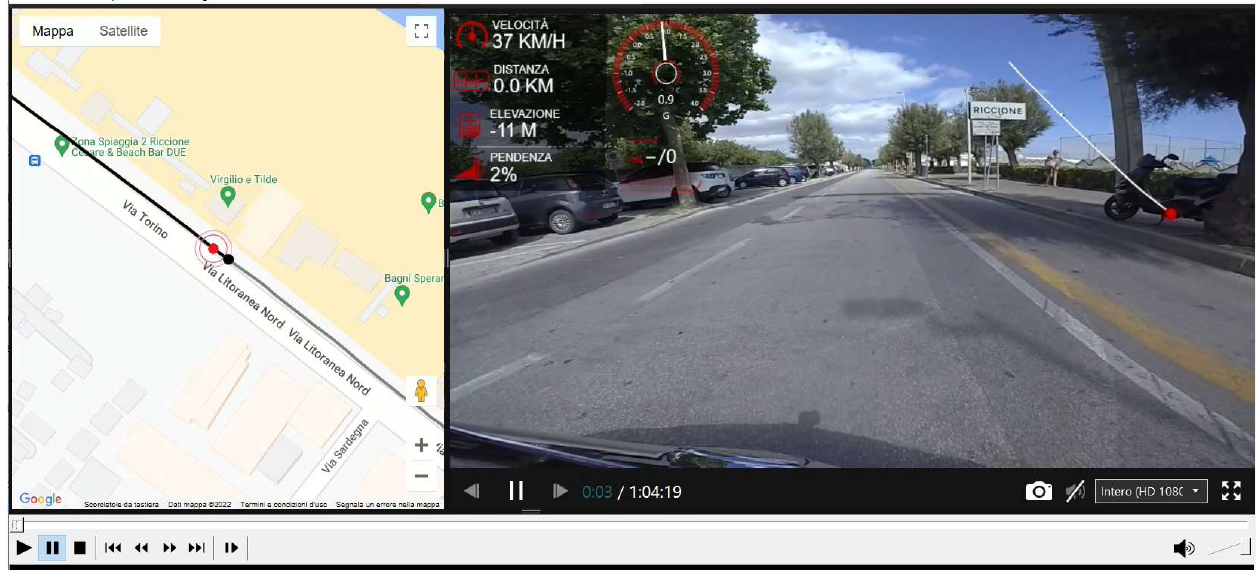
Figure 4. Example of a video framework integrated in a GIS database.